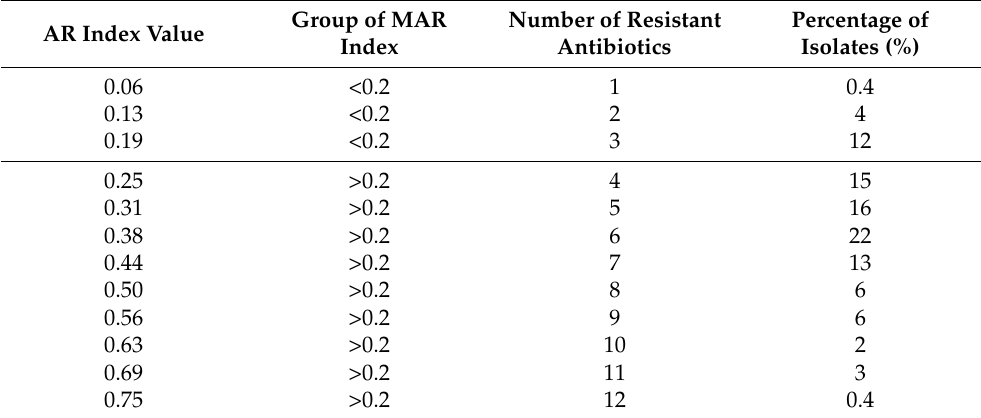
Table 5. The overall of MAR index of Vibrio spp. collected from seven shrimp farms in different geographical regions of Peninsular